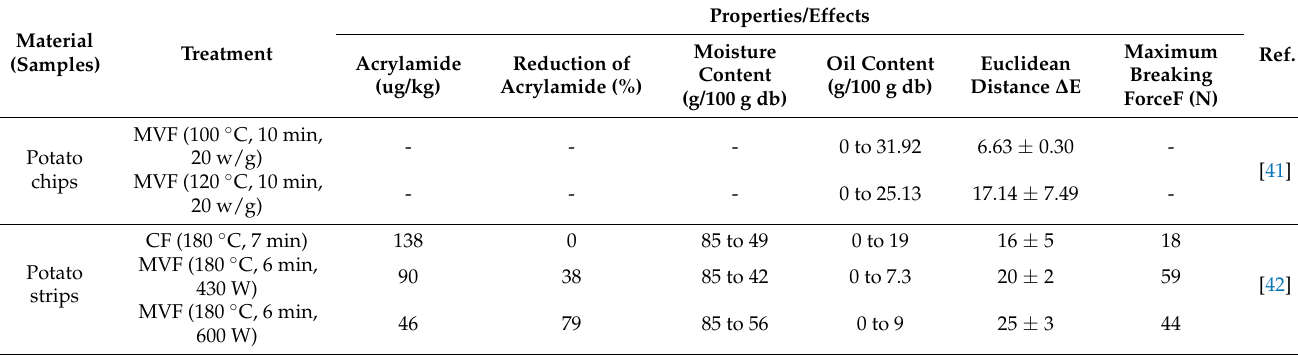
Table 4. Effects of microwave vacuum frying on different